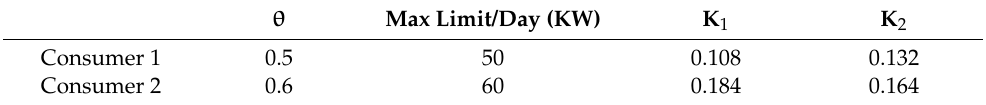
Table 6. Consumer type, daily power interrupt limits and cost coefficients for each